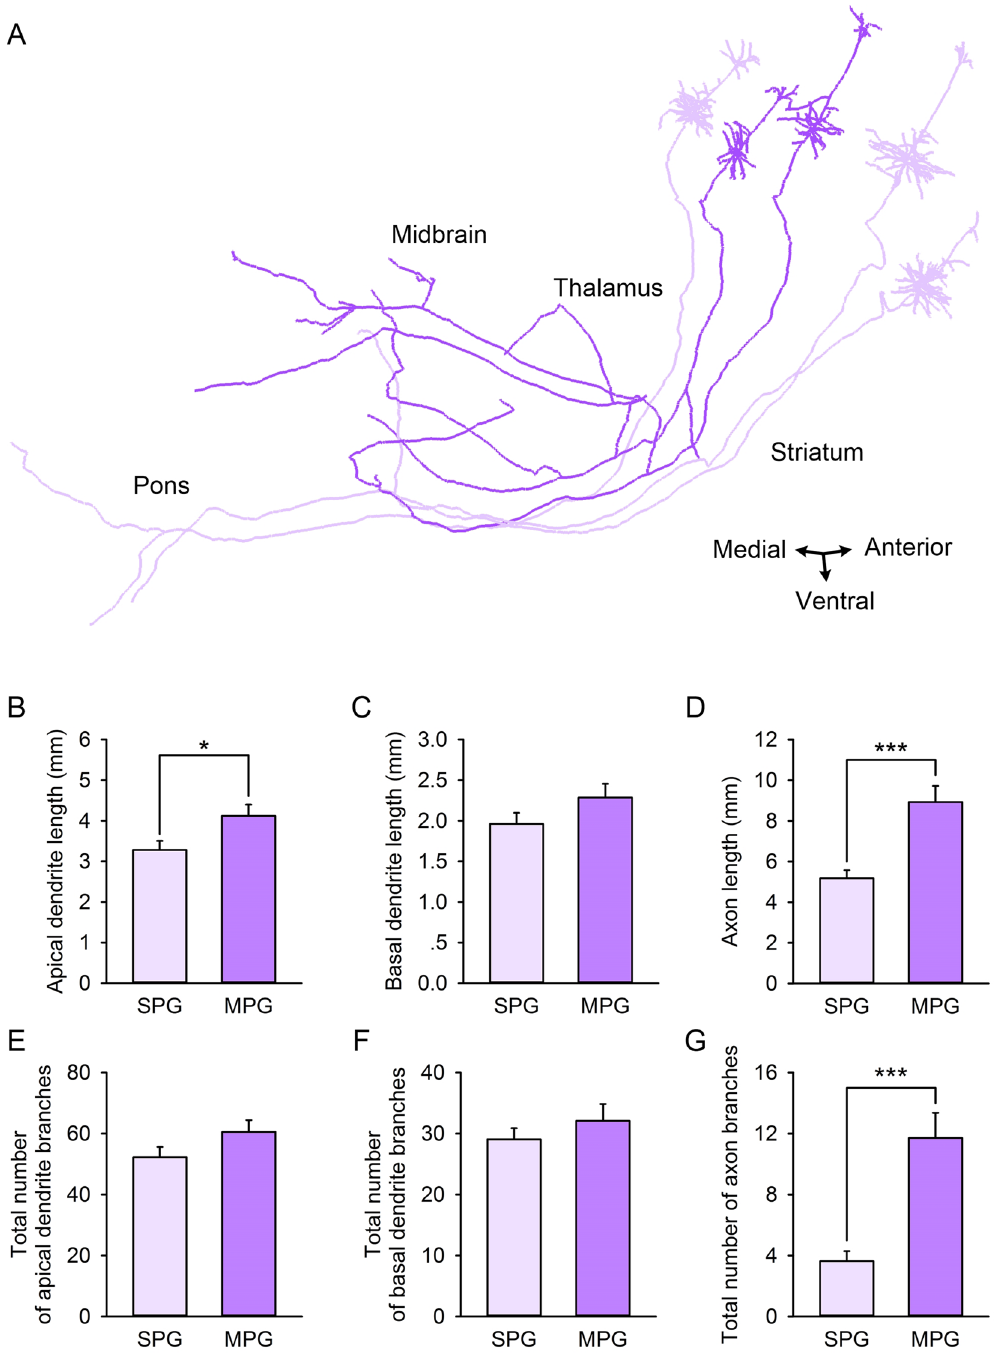
Figure 5. Comparative complexity of dendrites and axons between the single-region projection group (SPG) and the multi-region projection group (MPG). ( A ) Reconstruction samples of single-region projection neurons (n = 3, lavender) and multi-region projection neurons (n = 2, purple). Comparisons of apical dendrite length ( B ), basal dendrite length ( C ), axon length ( D ), total number of apical dendrite branches ( E ), total number of basal dendrite branches ( F ), and total number of axon branches ( G ) between the SPG and the MPG. SPG: n = 39; MPG: n = 28. * Represents p - value < 0.05, *** Represents p - value <